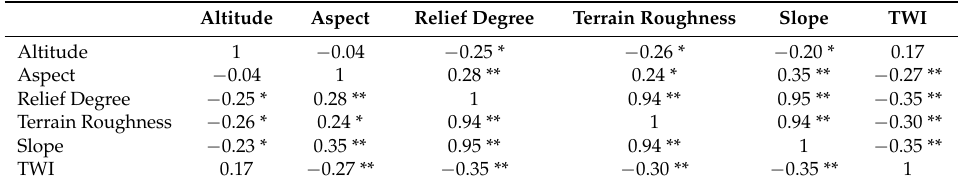
Table 1. Correlation coefficients between pairs of topographic variables. Altitude Aspect Relief Degree Terrain Roughness Slope TWI Altitude